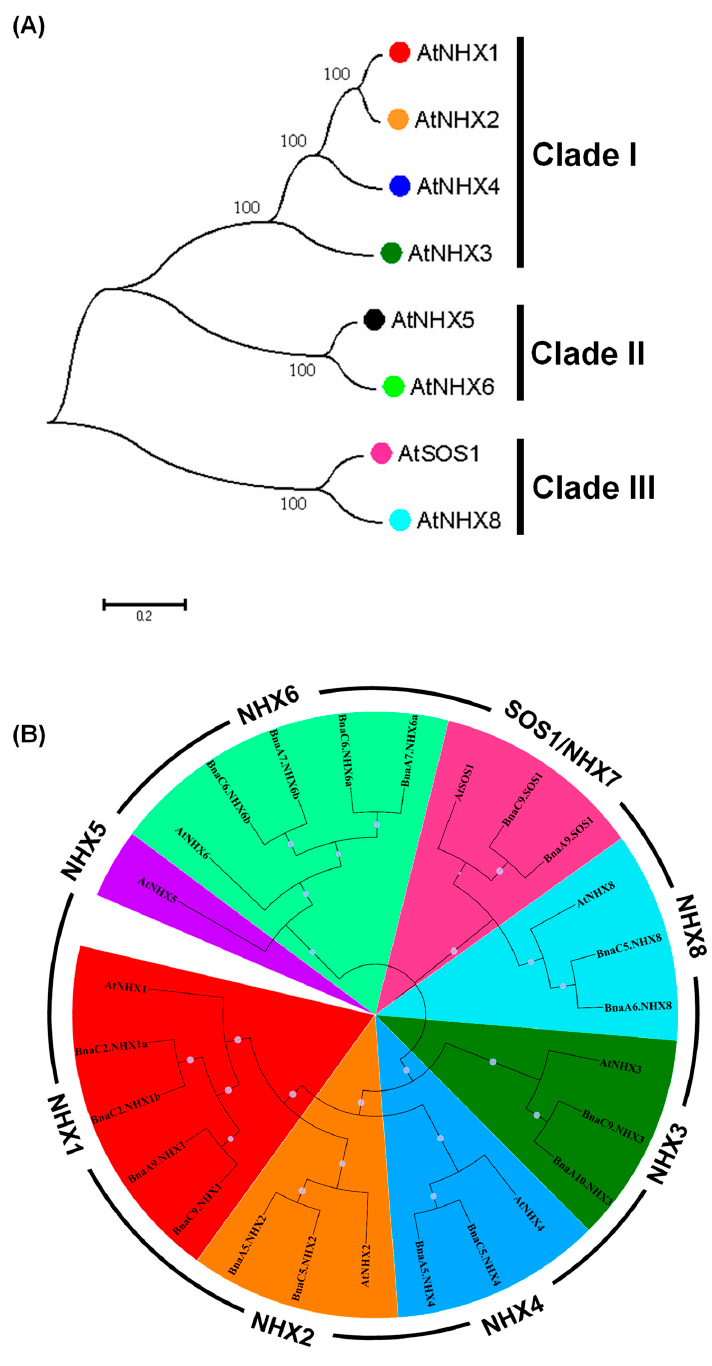
Figure3. Phylogeny analysis ofthe Na +/ H + antiporters (NHXs) in Arabidopsis thaliana and Brassica napus . Figure 3. Phylogeny analysis of the Na + /H + antiporters (NHXs) in Arabidopsis thaliana and Brassica napus . ( A – B ) Phylogeny analysis of AtNHXs ( A ) and the NHX homologs in B. napus ( A – B ) Phylogeny analysis of AtNHXs ( A ) and the NHX homologs in B. napus ( B ). The NHX protein ( B ). The NHX protein sequences were multi-aligned using the ClustalW program, and then an sequences were multi-aligned using the ClustalW program, and then an unrooted phylogenetic tree unrooted phylogenetic tree was constructed using the software MEGA 6.06 with the neighbor- was constructed using the software MEGA 6.06 with the neighbor-joining method. The percentages of joining method. The percentages of replicate trees, in which the associated taxa clustered replicate trees, in which the associated taxa clustered together in the bootstrap test (1000 replicates), are shown next to the branches. The tree is drawn to scale, with branch lengths in the same units as those of the evolutionary distances used to infer the phylogenetic tree. The evolutionary distances were computed with the Poisson correction method and are in the units of the number of amino acid substitutions per